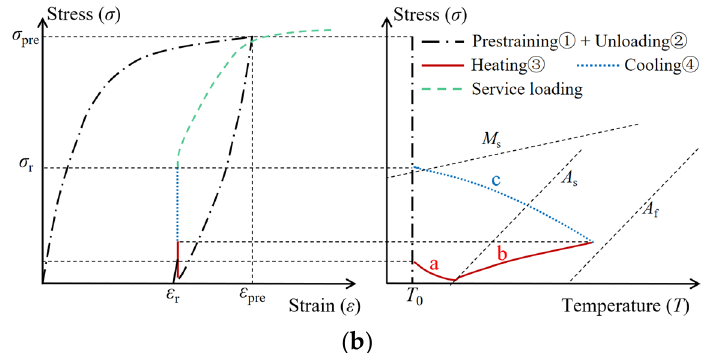
Figure 3. SME and activation performance of Fe-SMA: ( a ) SME, ( b ) activation performance.